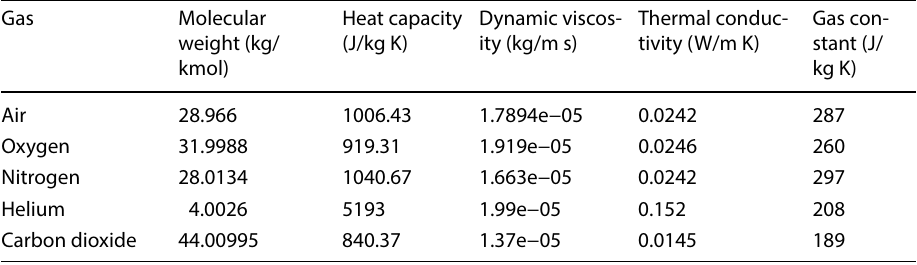
Table 3 Thermo-physical properties of the tested